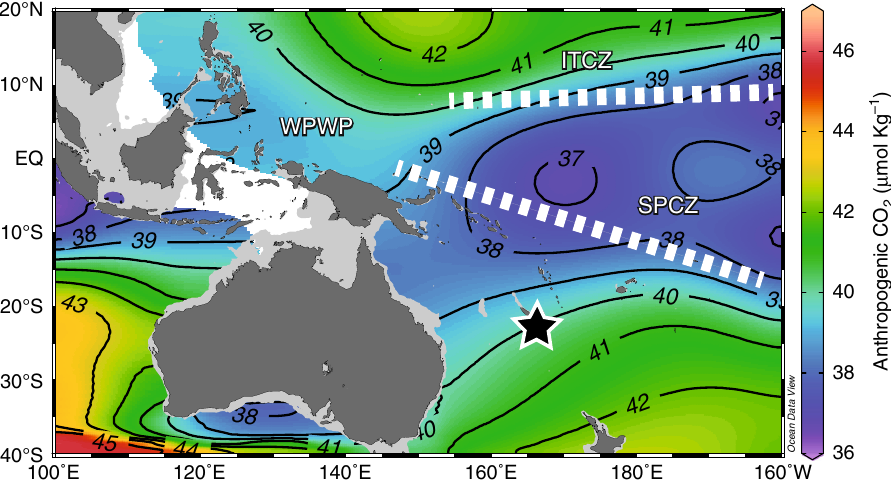
Fig. 1 Research location. Our research location at New Caledonia (22°21 ′ 47 S, 166°15 ′ 29 E; Star; Supplementary Fig. 1) is of high importance because it is located in the zone of transition from low to high amounts of anthropogenic CO 2 uptake 73 . The western Paci fi c warm pool (WPWP) with a permanent sea surface temperature above 28 °C in fl uences the climate of New Caledonia driving the steady convection in this region corresponding to the average precipitation axes of the Intertropical Convergence Zone (ITCZ) and South Paci fi c Convergence Zone (SPCZ). Map is produced using Ocean Data View ver. 4.7.4 (ref. 74 ) (http://odv.awi.de) and modi fi ed